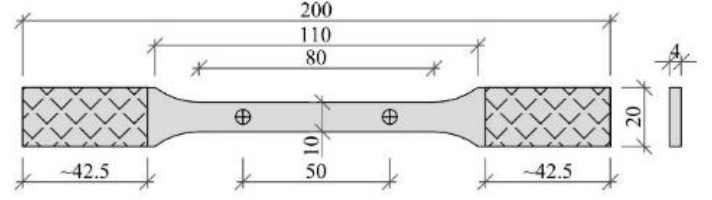
Figure 1. Geometry of tested specimen.